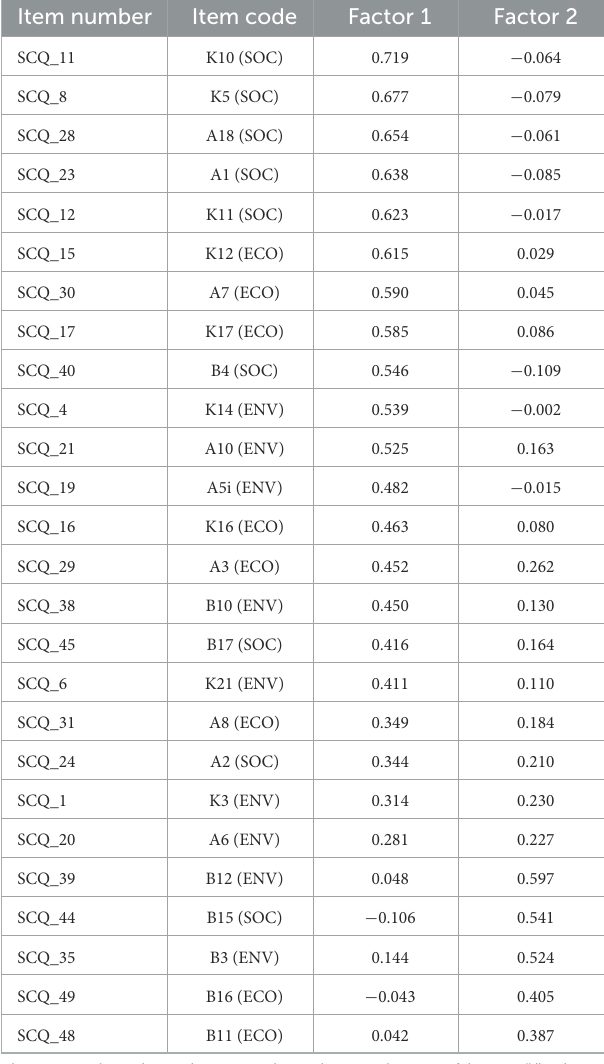
TABLE 1 Rotated component matrix for two factor